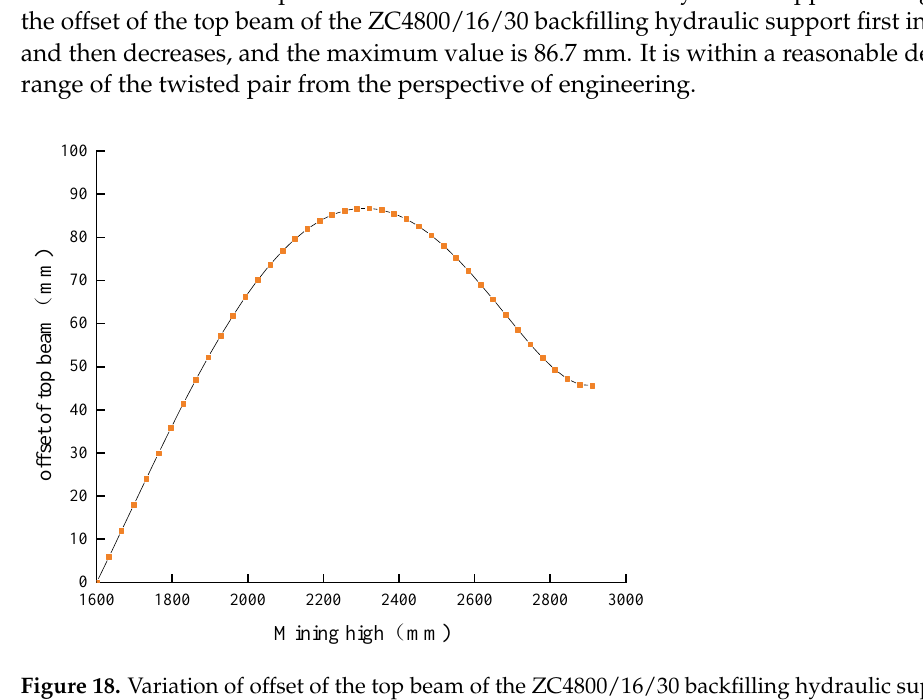
Figure 18. Variation of offset of the top beam of the ZC4800/16/30 backfilling hydraulic support.